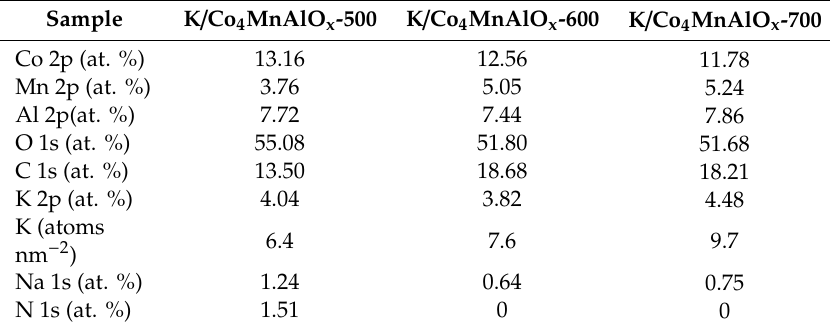
Table 3. Surface concentration determined using X-ray photoelectron spectrometry. Sample K / Co 4 MnAlO x -500 K / Co 4 MnAlO x